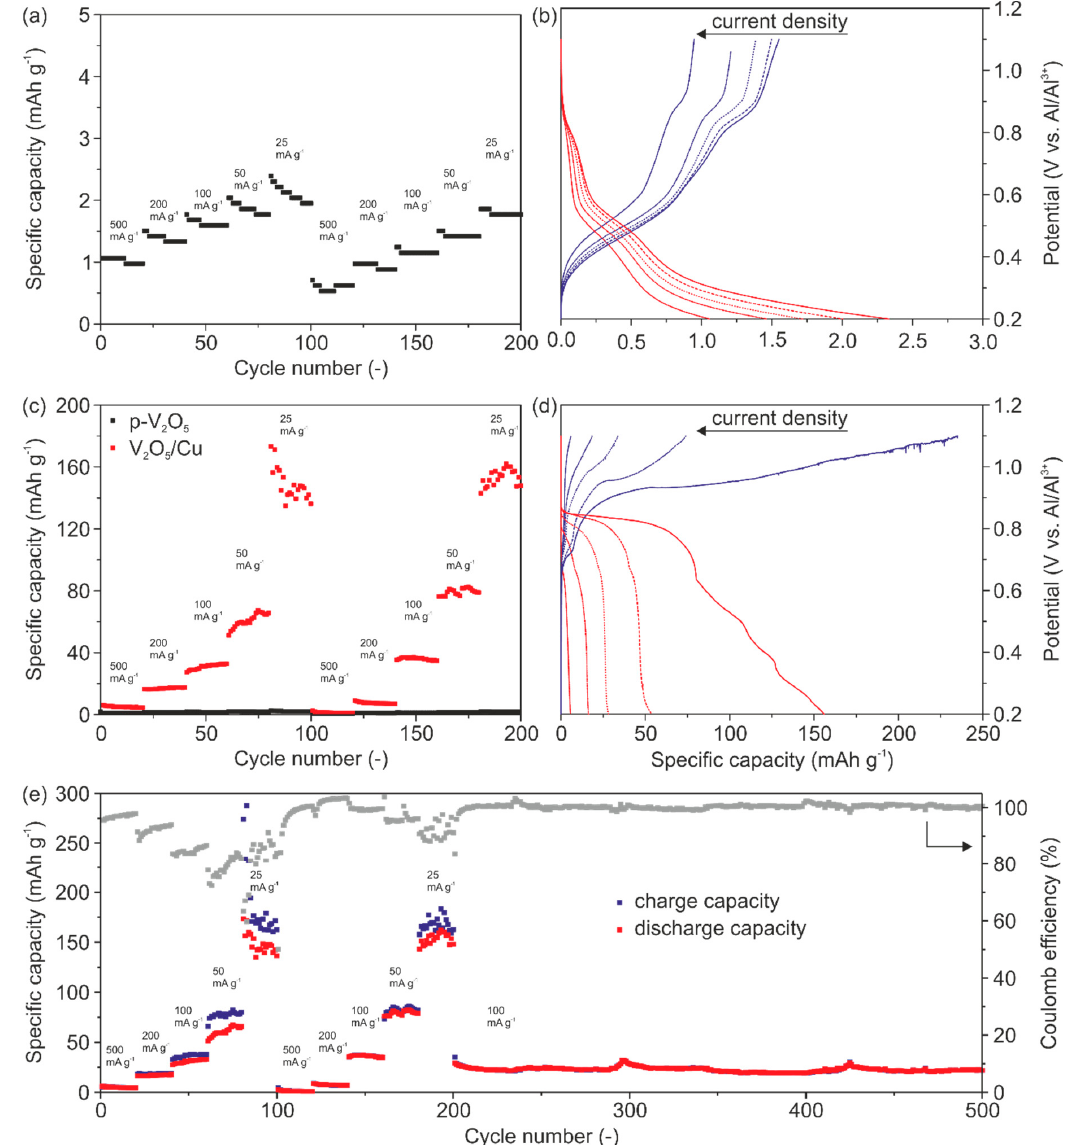
Figure 6. Galvanostatic charge and discharge measurements with various current densities, as displayed in the diagrams. Specific storage capacity as a function of the cycle number. ( a ) Specific discharge capacity of p ‐ V 2 O 5 . ( b ) Potential vs. specific capacity plot for p ‐ V 2 O 5 . ( c ) Specific discharge capacity of p ‐ V 2 O 5 and V 2 O 5 /Cu. ( d ) Potential vs. specific capacity plot for the V 2 O 5 /Cu. ( e ) Charging/discharging capacity and Coulomb efficiency of the V 2 O 5 /Cu